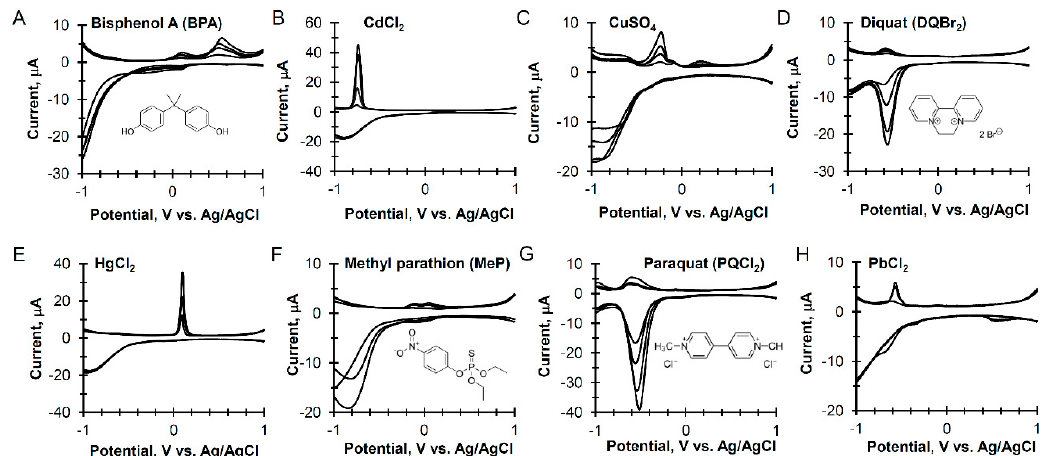
Figure 3. Cyclic square wave voltammetry of seawater spiked with environmental contaminants with increasing concentration from 100 to 2000 ppb using a multilayer graphene as the working electrode and parameters listed in Figure 2A.